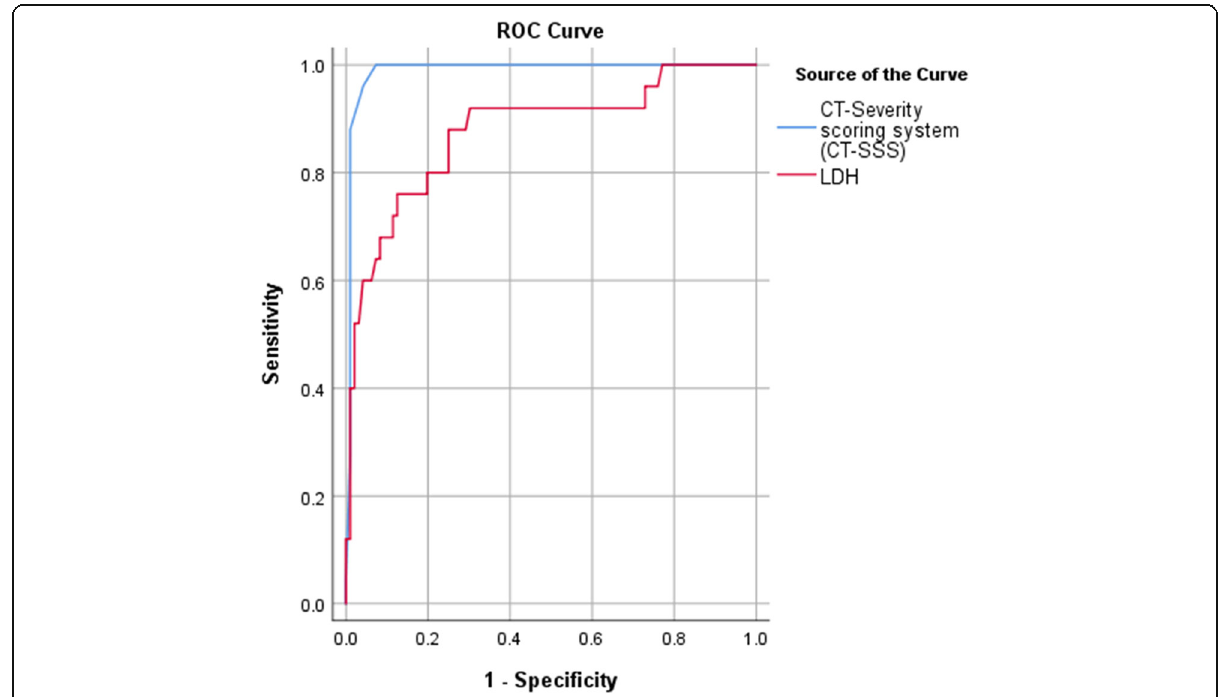
Fig. 7 ROC curve for critical cases using CT-SSS and